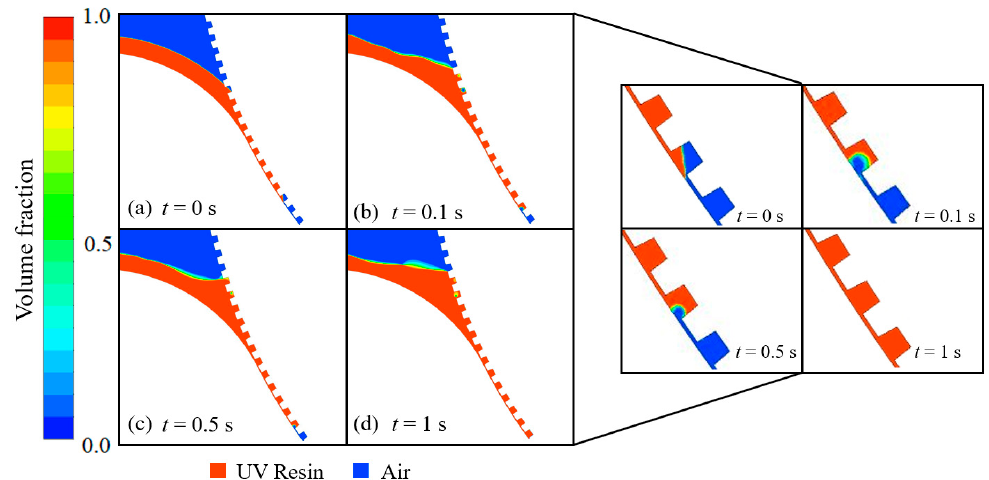
Figure 6. UV resin complete filling into the rectangular microcavities with a tapering angle of 5° at two ends of the roller mold at different times: ( a ) t = 0 s, ( b ) t = 0.1 s, ( c ) t = 0.5 s, and ( d ) t = 1 s, at a PET web speed of 24.2 mm / s ( θ R = 15 ◦ , θ P = 60 ◦ ).